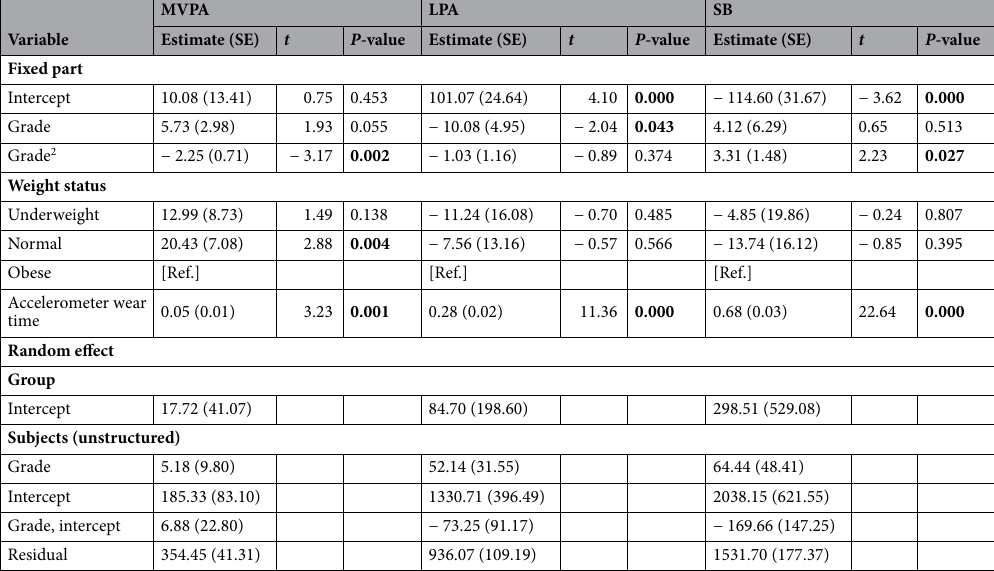
Table 3. Linear mixed models using the restricted maximum likelihood method without adjustments for the fixed effect of sex and the interaction between sex and grade in this five-year longitudinal study on physical activity in children transitioning from primary to secondary school. Estimated values of the fixed and random effects are reported by the regression coefficient and variance, respectively. Group effect describes the two groups recruited in grade 4 in 2015 (n = 32) and 2016 (n = 31), with differences at the time of baseline data collection. Significant values are in bold. MVPA moderate-to-vigorous physical activity, LPA light physical activity, SB sedentary behavior, SE standard error, Ref reference